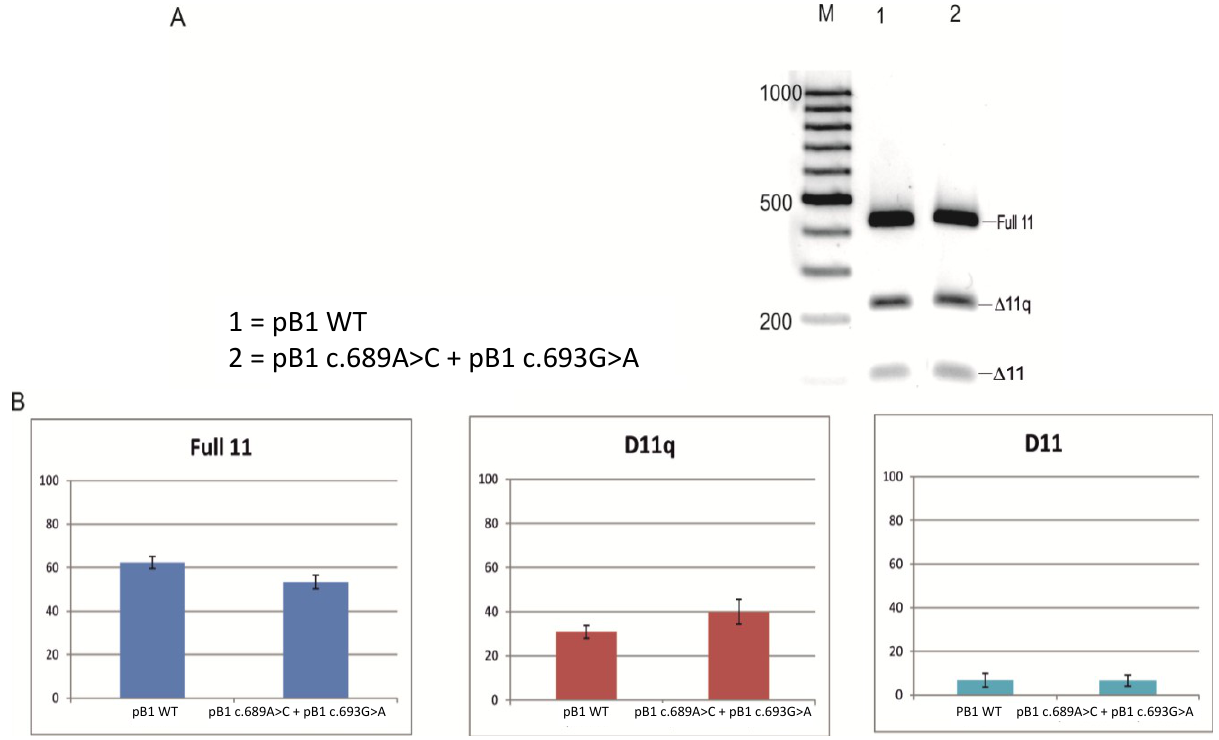
Figure 5. Minigene carrying the double mutant. ( A ) Splicing product for the pB1 WT minigene ( Lane 1 ) and the minigene with the double mutant ( Lane 2 ). On the right of the gel is a schematic representation of the three splicing isoform corresponding to each of the three bands: the Full 11, the Δ11q and Δ11 isoforms. M is the 100-bp DNA ladder marker; ( B ) The lower panel shows the percentage (%) of the Full 11, Δ11q and Δ11 isoforms, respectively, calculated against the total expression of the three isoforms. The intensity of the each band was calculated using Image